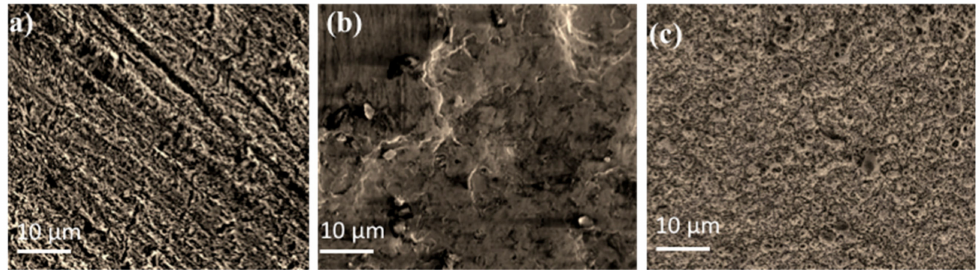
Figure 15. SEM images taken from the evaporator after continuous operation with nanofluid, ( a ) wt. % = 0.025, ( b ) wt. % = 0.075, ( c ) clean surface (and also the case of working with acetone had the same roughness